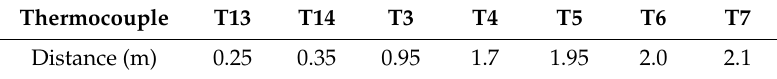
Table 3. Distance of individual thermocouples from burner